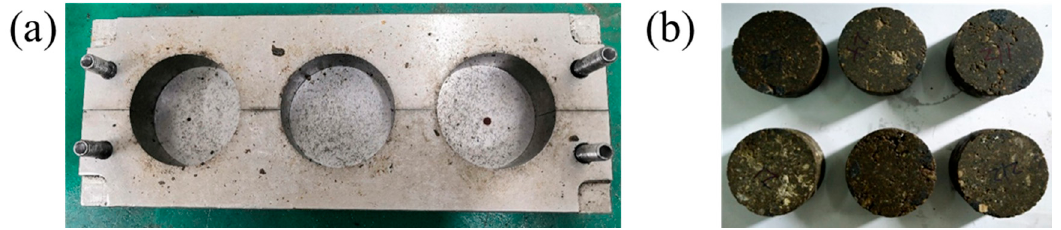
Figure 2. ( a ) Metal mold and ( b ) specimen after demolding .